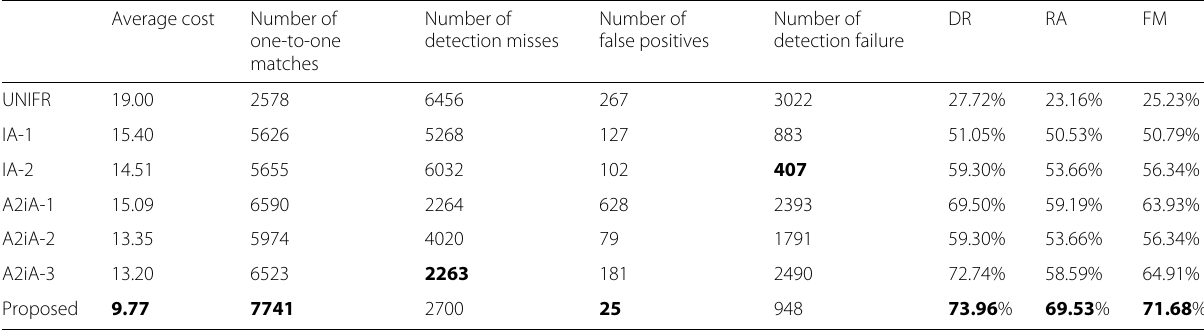
The highlighted values show the best